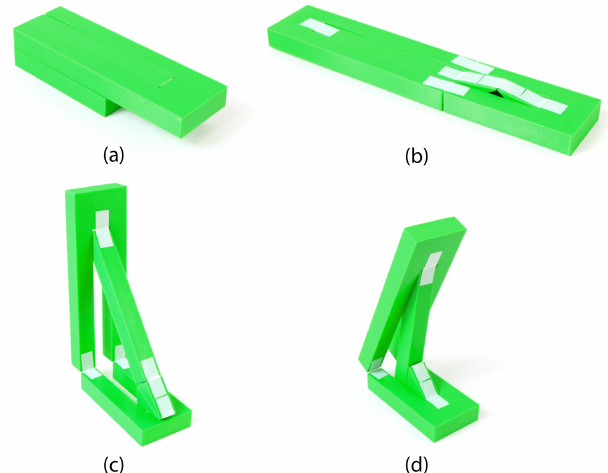
Figure 13. Flat-foldable planar deploying strut ThUDS with strut (link 3) split. Shown as (a) flat folded, (b) flat, (c) deployed, and (d) in an undesired state due to the added degree of freedom.